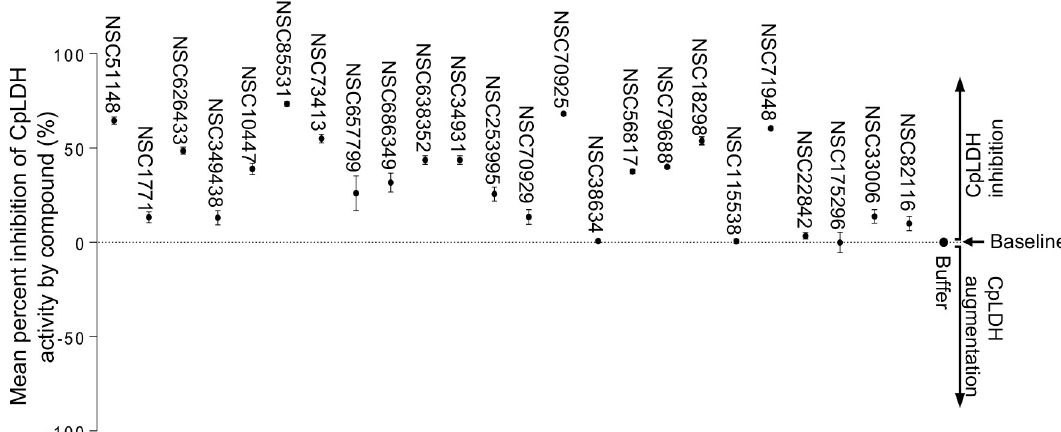
Fig 3. Effect of the Mechanistic Set IV compounds on the catalytic activity of recombinant CpLDH protein. Individually reconstituted compounds were used at a final concentration of 20 μ M in the reaction for the reduction of pyruvate to lactate with recombinant CpLDH protein as enzyme. The mean percent inhibition of CpLDH activity by each compound was derived by dividing the mean change in optical density ( Δ OD 340 ) of the reaction after 2 min in the presence of the compound by the mean Δ OD 340 of the reaction without compound, and multiplying the product by 100. The baseline mean percent inhibition of 0 (buffer) was for the reaction without compound, but with an equivalent volume of solvent used to reconstitute compound. Compounds with mean percent inhibition values greater than 0 were designated as inhibitors of the activity of CpLDH, while those with mean percent inhibition values less than 0 were classified as augmenters (data points below 0 that are not shown in Fig 3 were 765 in total, and are listed in S4 Table together with their corresponding CpLDH percent inhibition values). Each reaction was performed in triplicate, and the data shown represents means of three independent experiments.